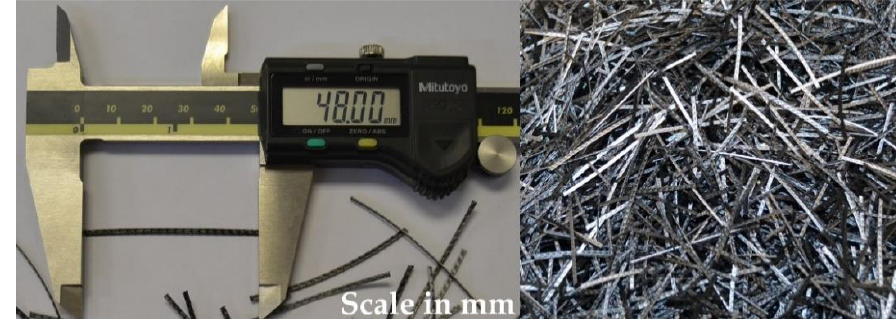
Figure 2. Visual aspect of the polyolefin fibres.